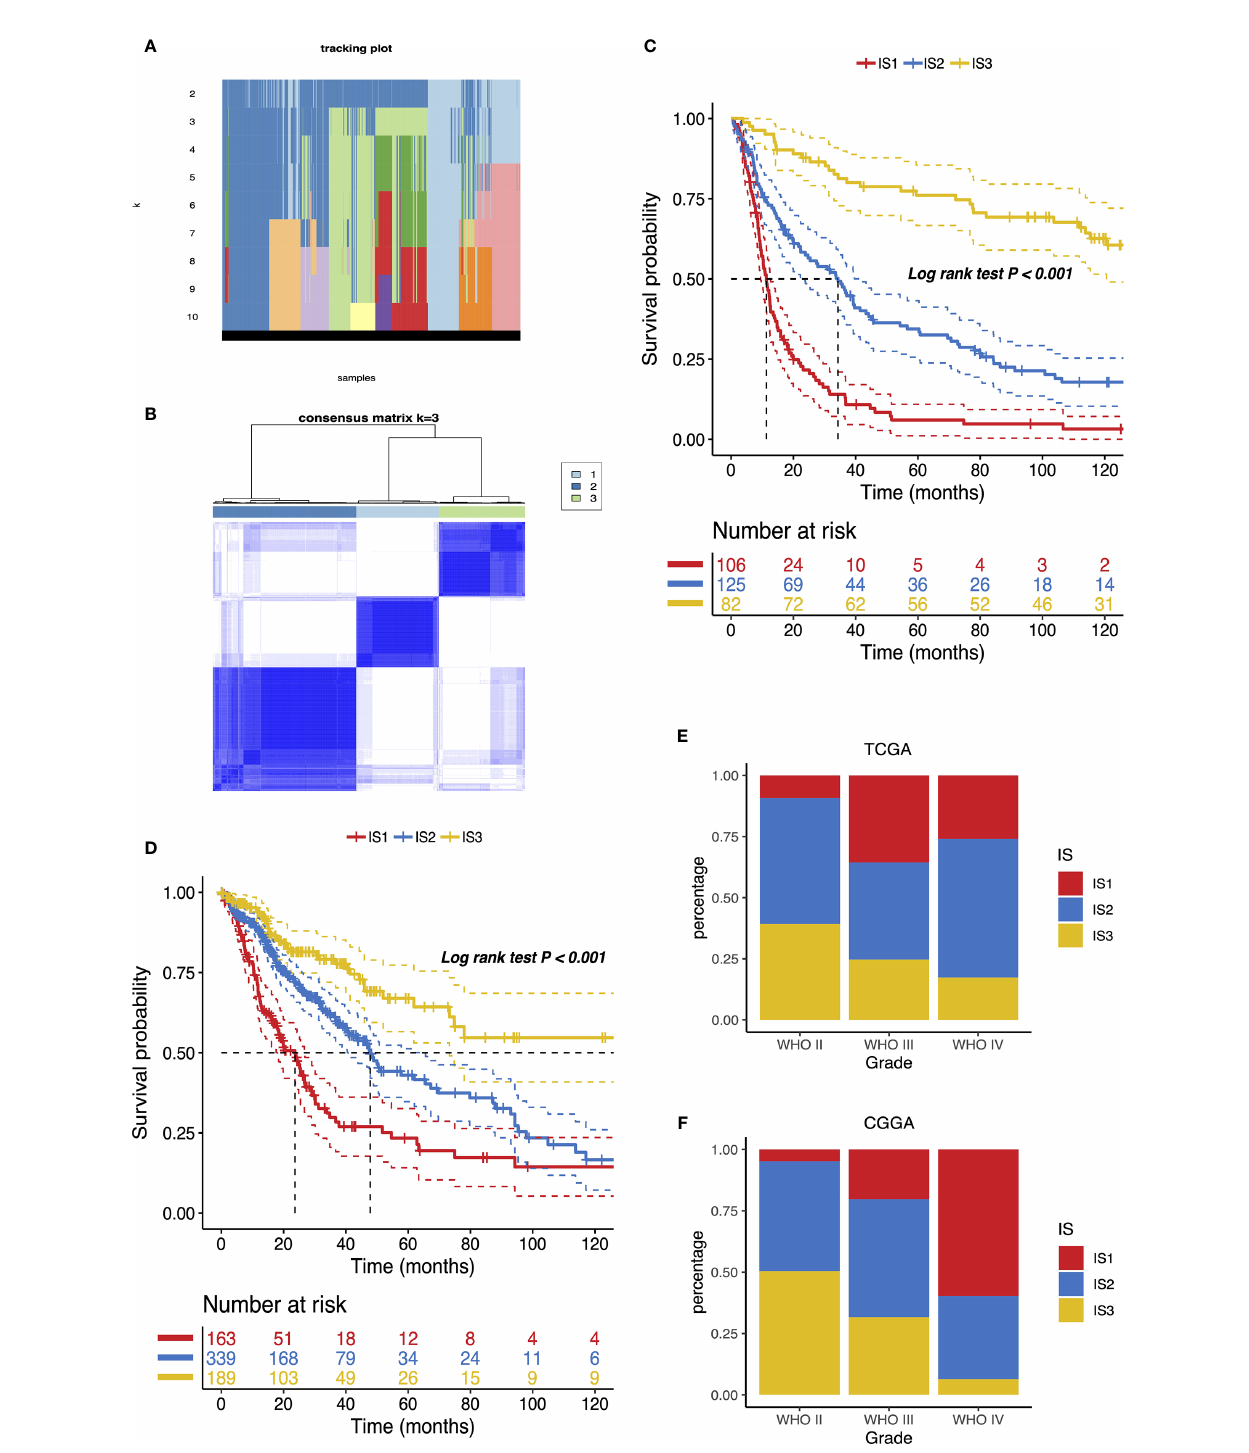
FIGURE 4 | Identi fi cation of potential immune subtypes of glioma. (A) Tracking plot of k in the consensus cluster of immune-related genes. (B) Sample clustering heat map. Kaplan – Meier curves showing OS of glioma immune subtypes in CGGA (C) and TCGA (D) cohorts. Distribution of IS1 – IS3 across glioma WHO grades II to IV in CGGA (E) and TCGA (F)